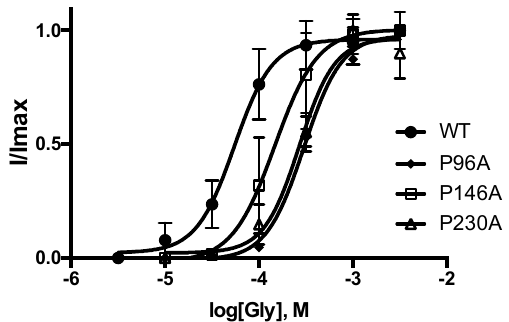
Figure 2. Concentration response curves for WT and mutant receptors derived from maximal responses (see Figure 3 for examples). Data = mean ± SEM, n = 5. Parameters derived from these data are shown in Table 1.